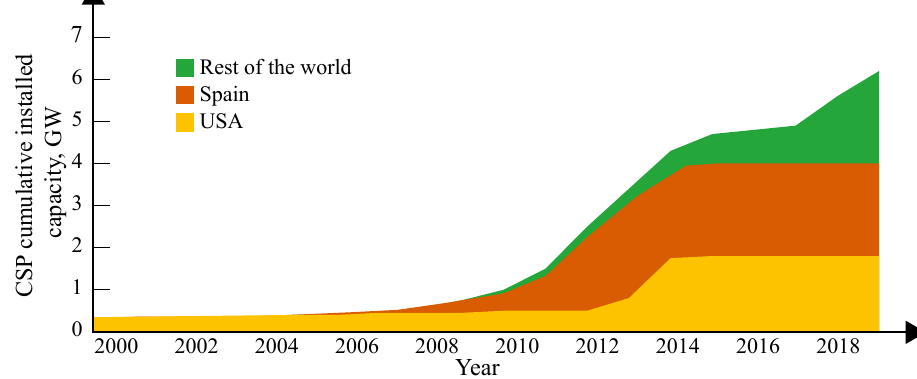
Figure 15. Cumulative installed capacity of CSP. The U.S. was the front-runner of installed CSP capacity, until Spain started deploying major CSP plants during the 2010s. Currently, Spain has the largest cumulative capacity for CSP plants, followed by the U.S.